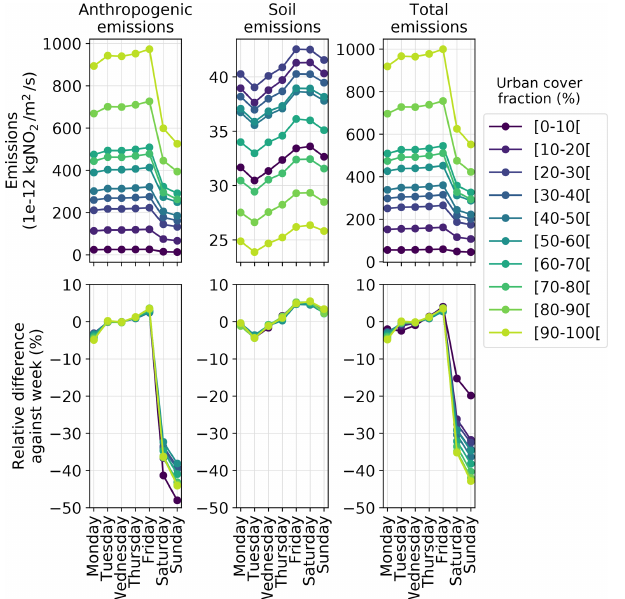
Figure 7. Similar to Fig. 6 for daily anthropogenic NO x emissions as obtained with the HERMESv3 model and natural soil NO emis- sions as calculated with MEGAN (both in kgNO 2 m − 2 s − 1 ).